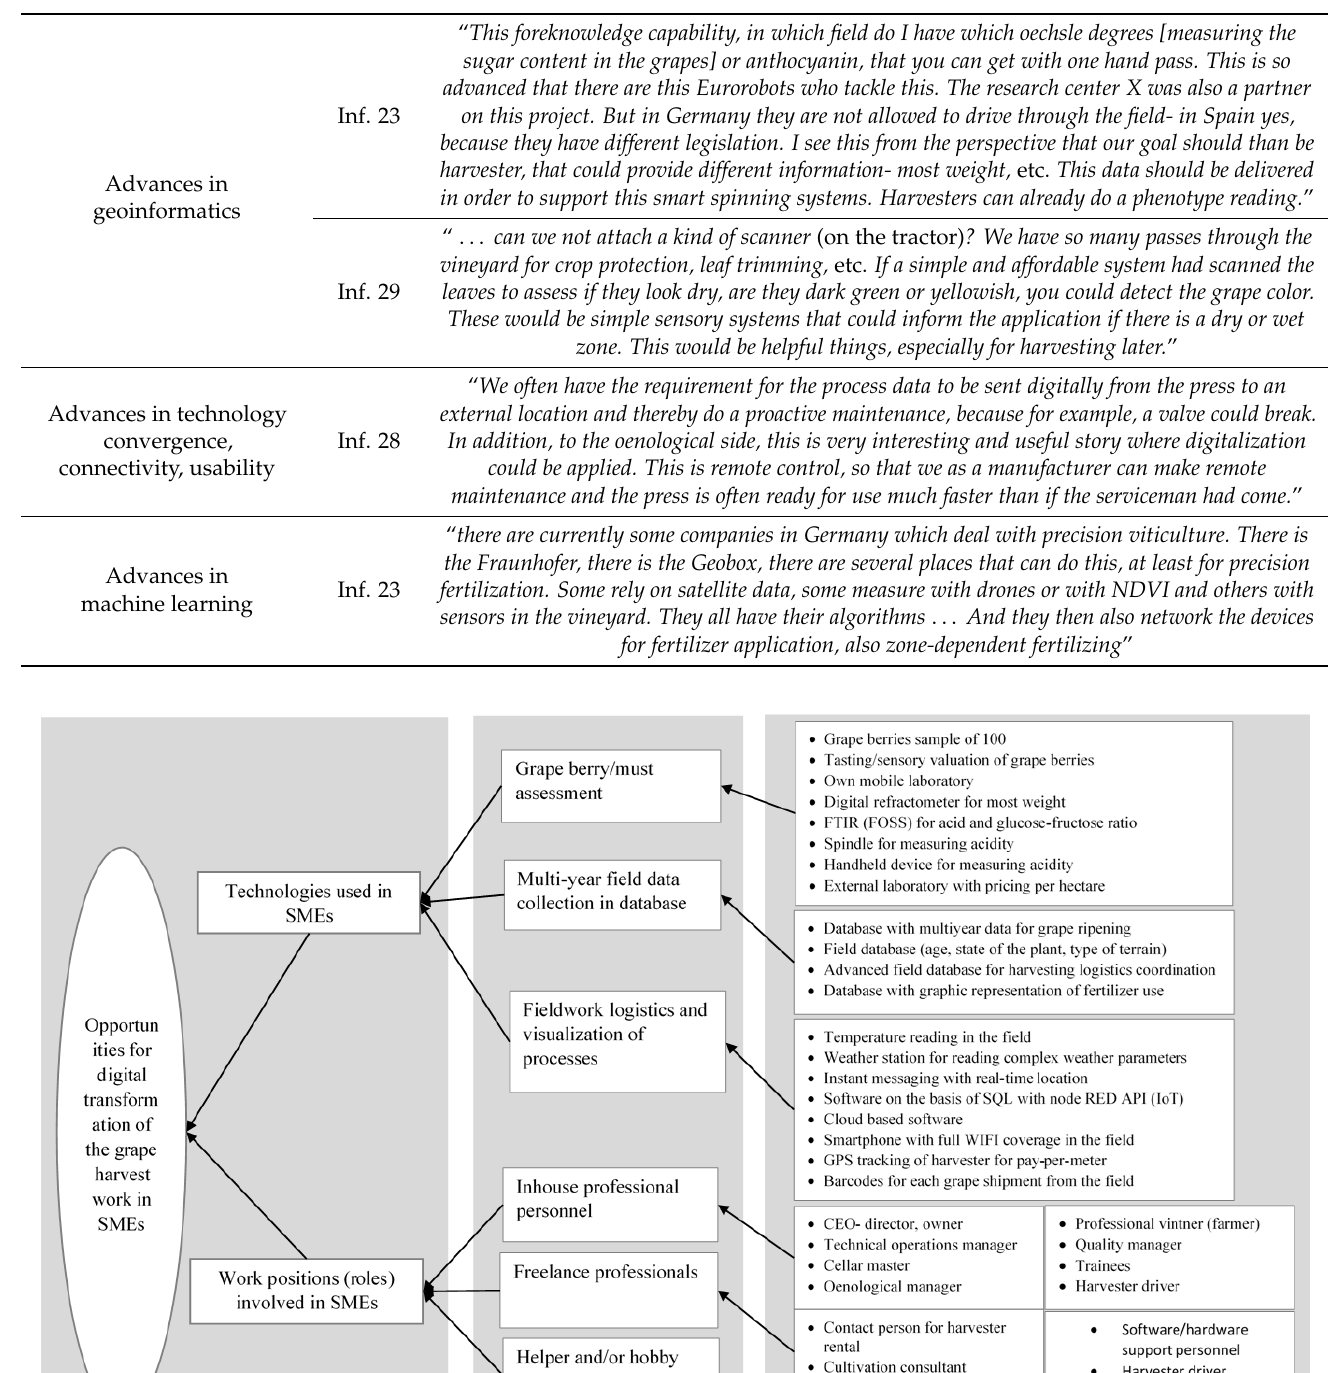
Table 3. Verbatim codes for company opportunities, fueling the push, DT strategies of wine SMEs.